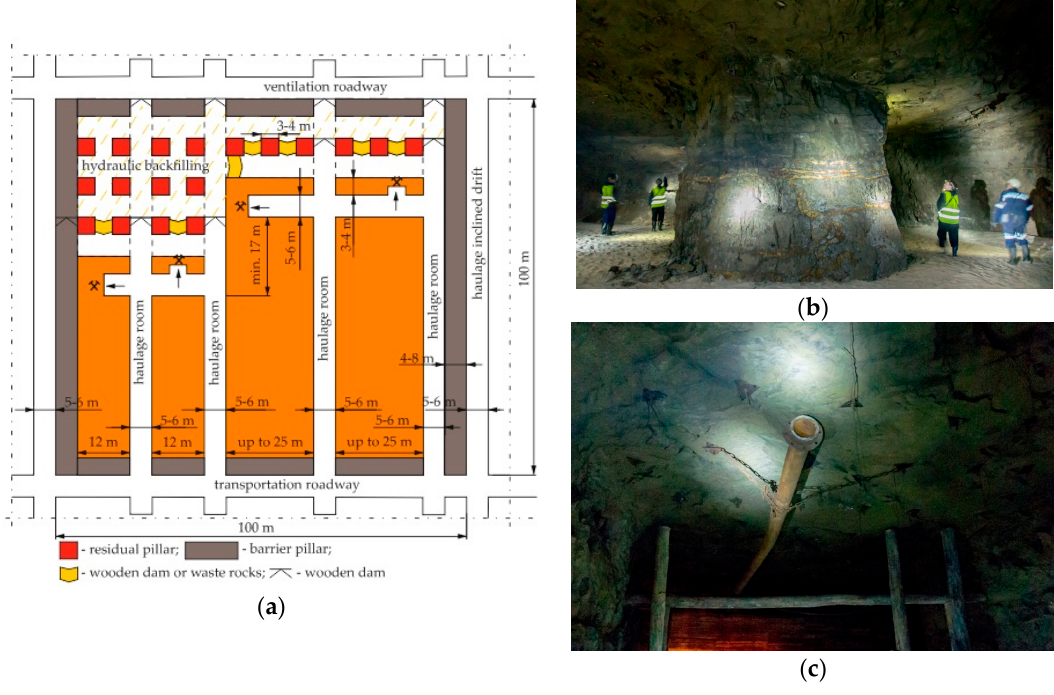
Figure 4. Room and pillar method with hydraulic backfilling: ( a ) Division of the exploitation field; ( b ) Technological pillar with sphalerite and galena minerals in the Olkusz-Pomorzany mine in Poland; ( c ) Construction of a wooden filling dam with a filling pipeline.